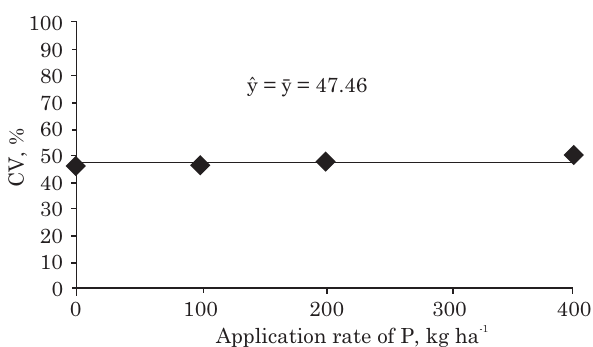
Figure 3. Mean coefficients of variation of yield in high plant density coffee as a function of rates of P 2 O 5 applied for the four sources of P used over the period of four crop